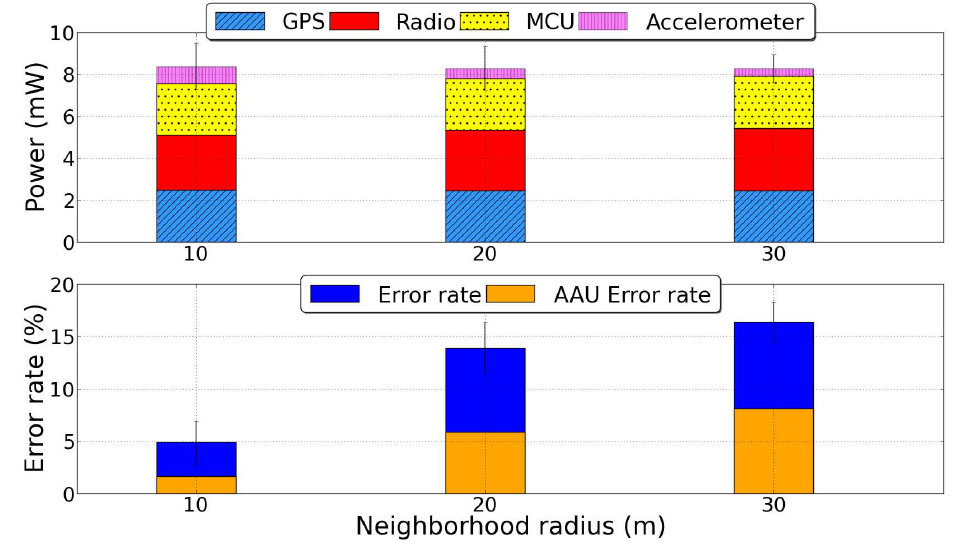
Figure 18. Performance with different group radius. Benefits from group-based duty cycling decrease for smaller